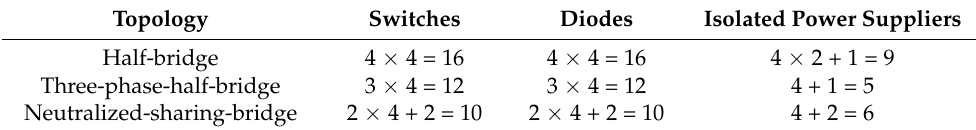
Table 1. Comparisons of component numbers with three topologies for the four DOF AMB. Topology Switches Diodes Isolated Power Suppliers